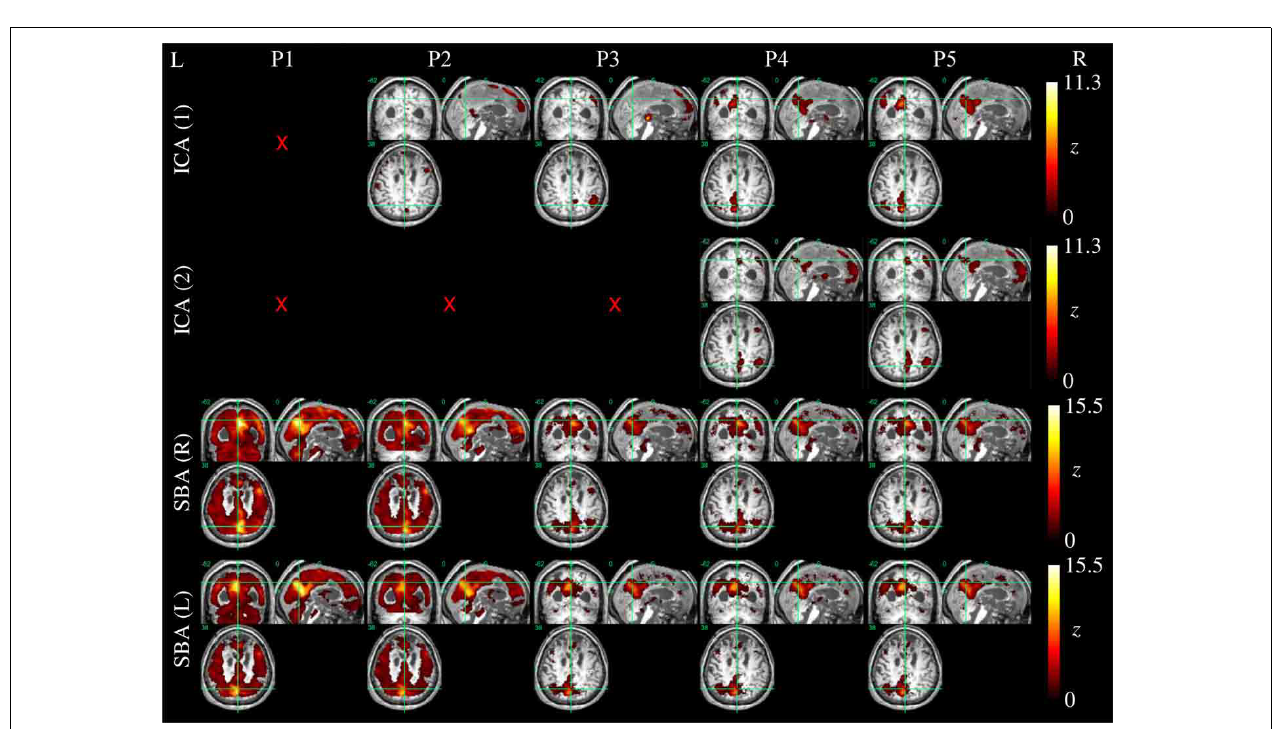
FIGURE 7 | DMN functional connectivity maps computed with ICA (top row) and SBA (middle and bottom rows) for a patient with a clinical diagnosis of vegetative state (maximum displacement 0.8mm, 3/200 outlier volumes); red crosses denote inability to identify DMN activity in any of the 20 components extracted by